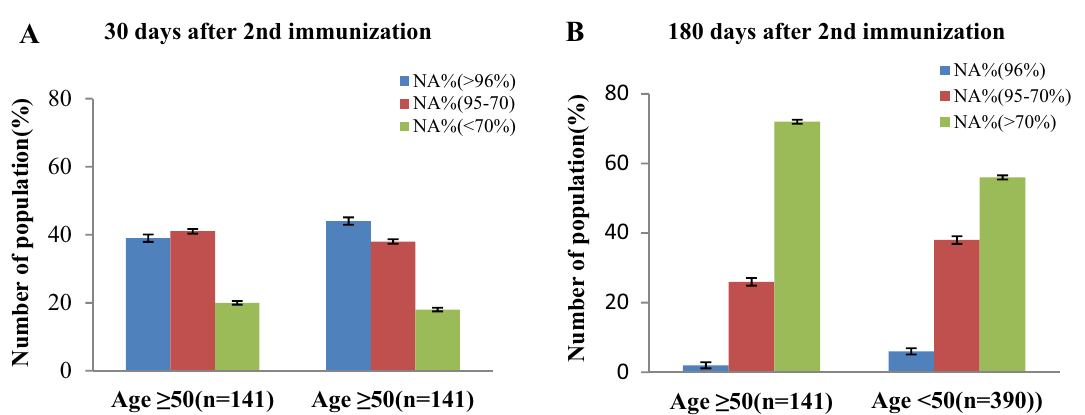
Figure 2. Percentage (%) of people with an immune response based on age group after 30 days ( A ) and 180 days ( B ) from 2nd immunization completion.